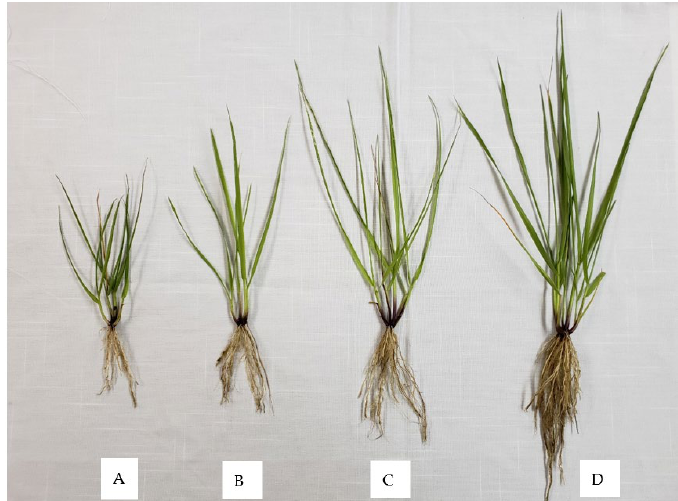
Figure 1. Effects of different concentrations of selenium nanoparticles (SeNPs) applied by foliar route on the characteristics of forage grasses ( Festuca arundinacea Schreb .): ( A ) Control 0; ( B ) 1.5 ppm; ( C ) 3.0 ppm; ( D ) 4.5 ppm.